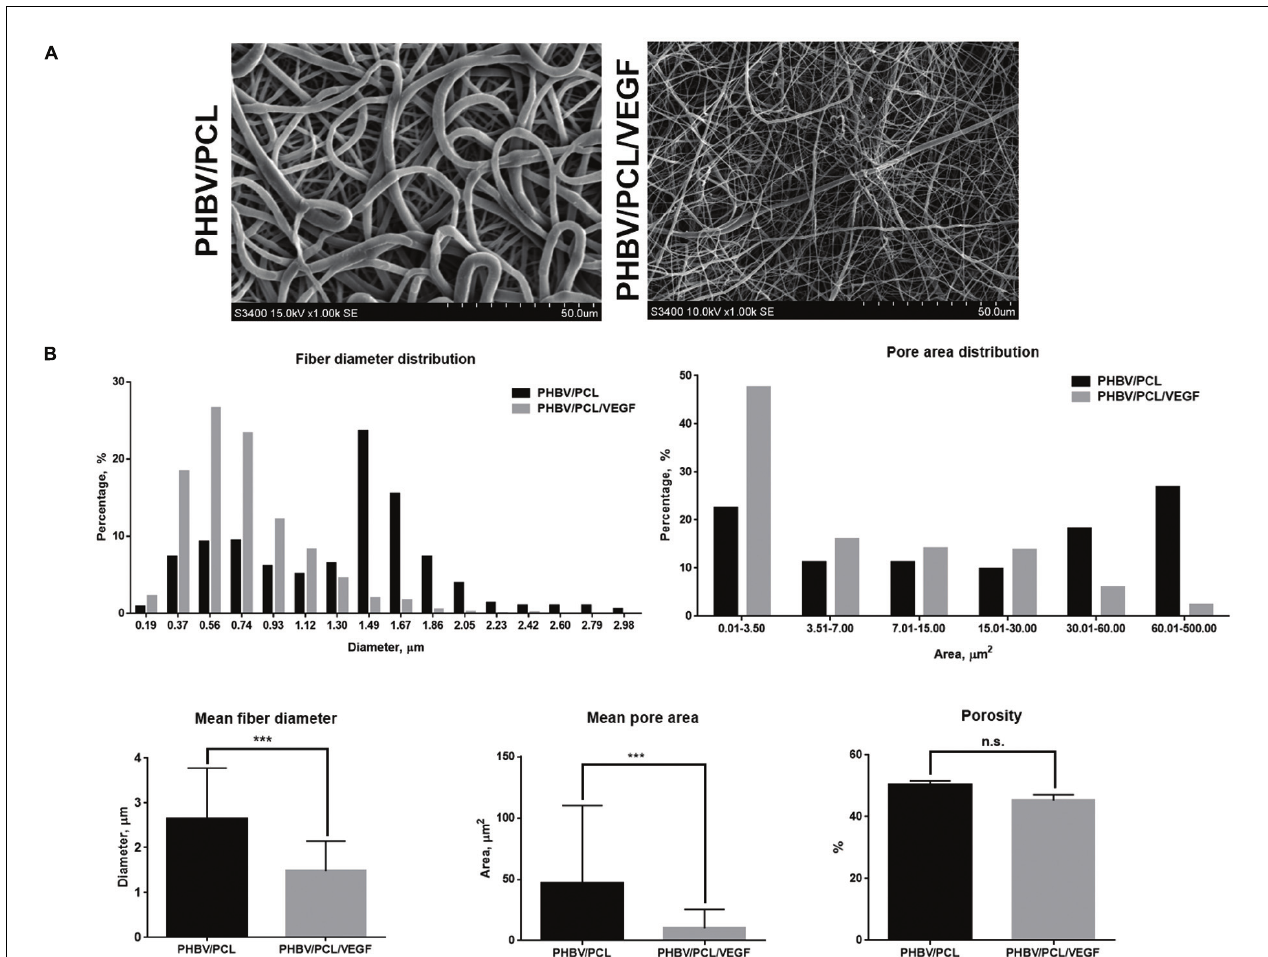
FIGURE 1 | Morphology of PHBV/PCL vascular grafts with and without VEGF. (A) Scanning electron microscopy images; (B) Quantitative image analysis (five images containing in total > 100 fibers and pores per group) showed that PHBV/PCL grafts with and without VEGF consisted mostly of nanoscale fibers/small pores and microscale fibers/large pores, respectively. Moreover, it revealed a lower mean fiber diameter and mean pore area in PHBV/PCL grafts with VEGF compared to those without. Data are represented as mean with standard deviation, ∗∗∗ P < 0.001, two-tailed Student’s t -test.